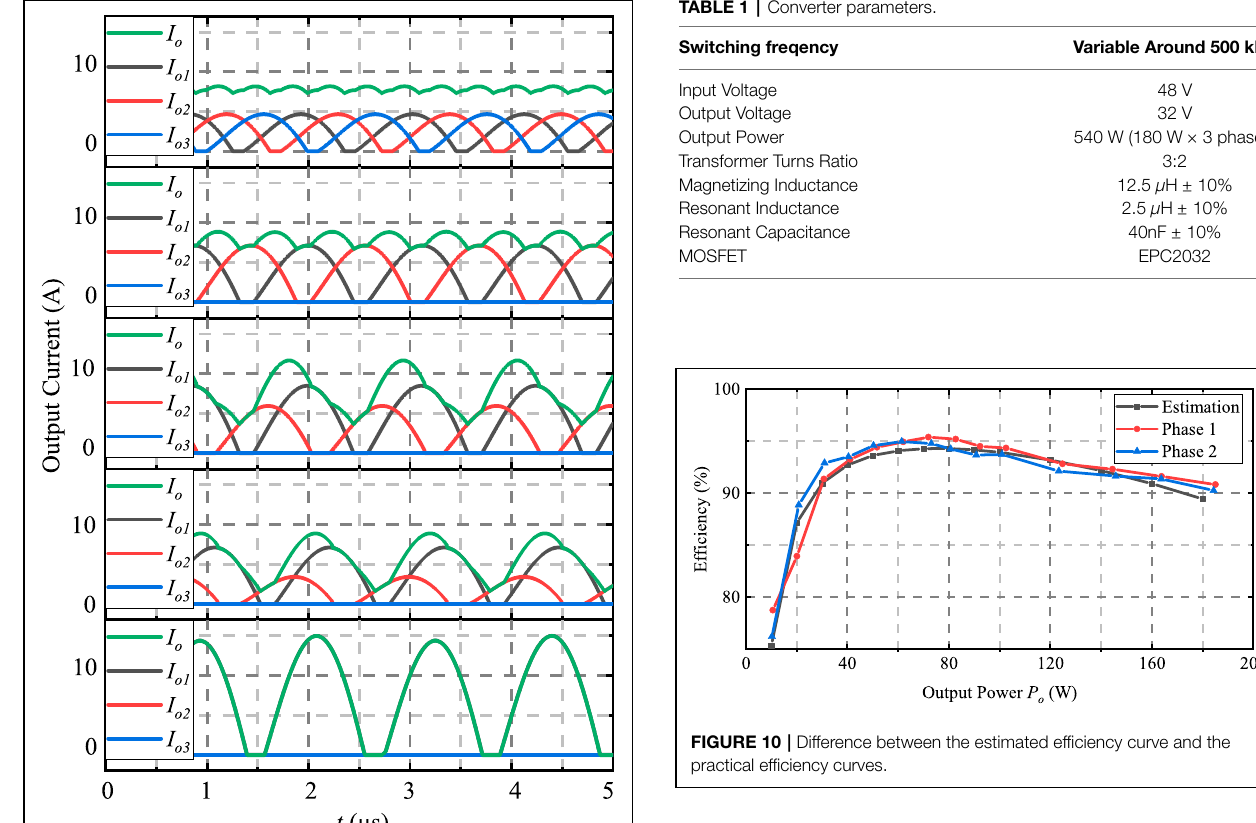
simulation shown as Figure 8 . From top to bottom are five